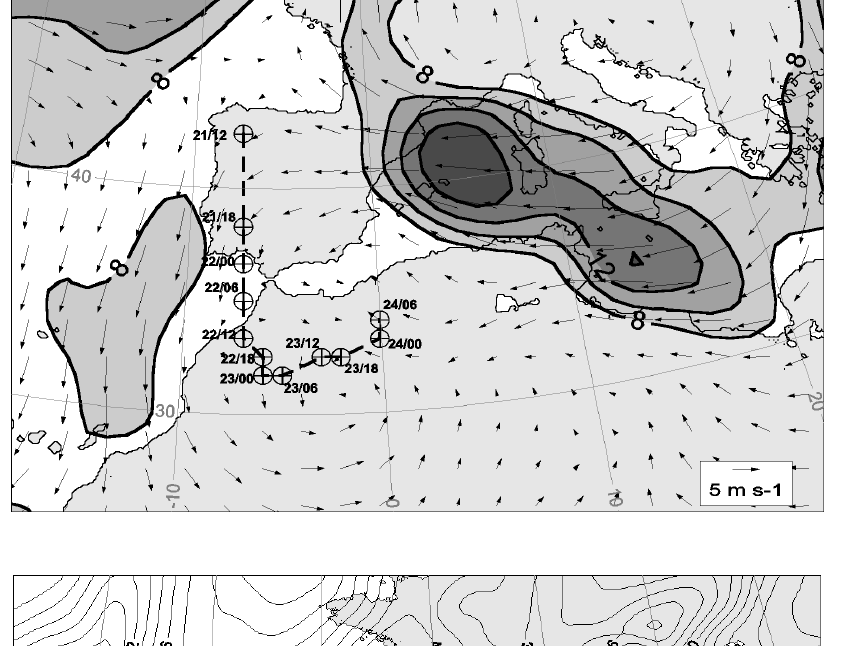
Fig. 8. Position of the cutoff low cen- ter at 300hPa (circled crosses), from 12:00UTC 21 to 06:00UTC, 24 Octo- ber 2000as simulated in the control run (zoom on domain 1). Vector field and shaded contours show the 48-h aver- aged wind and wind speed (m/s) greater than 8m/s at 1000hPa from 00:00UTC 22 to 00:00UTC, 24 October 2000.